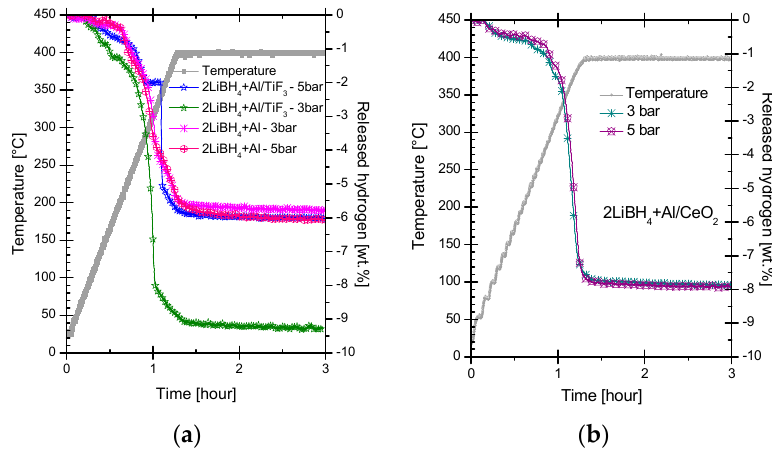
Figure 4. Temperature programed hydrogen desorption of ( a ) 2LiBH 4 + Al, and 2LiBH 4 + Al/TiF 3 ; ( b ) 2LiBH 4 + Al/CeO 2 at 3 and 5 bar initial pressure of hydrogen.